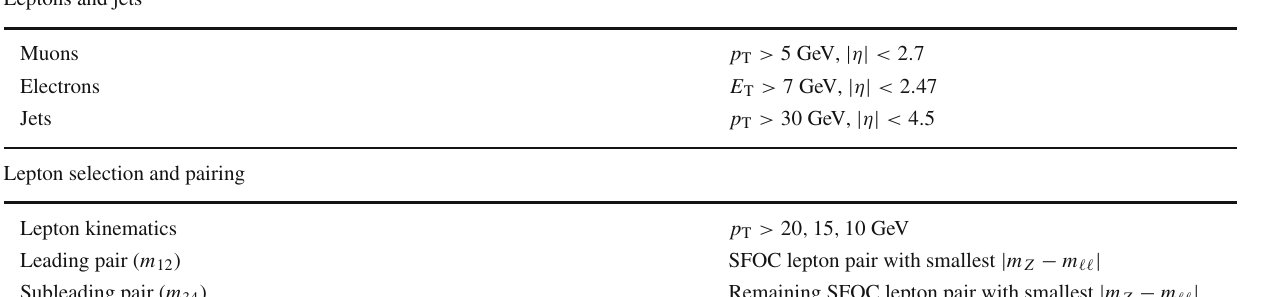
Table 2 A summary of event selection requirements for leptons and HiggsbosoncandidatesoutlinedinSect.4.SFOCleptonpairsaresame- flavour opposite-charge lepton pairs. For the mass requirement of the Leptons and